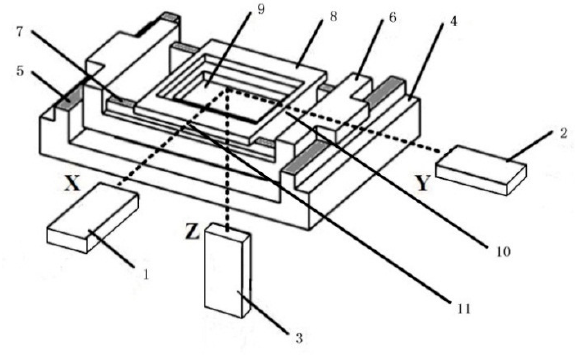
Figure 2. Schematic structure of 3D stage and schematic layout of metrological system. Schematic structure of 3D stage and schematic layout of metrological